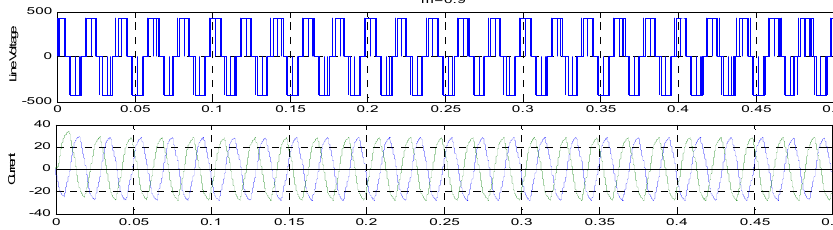
Figure 5. Simulation results of voltage and current at 0.9 modulation index.